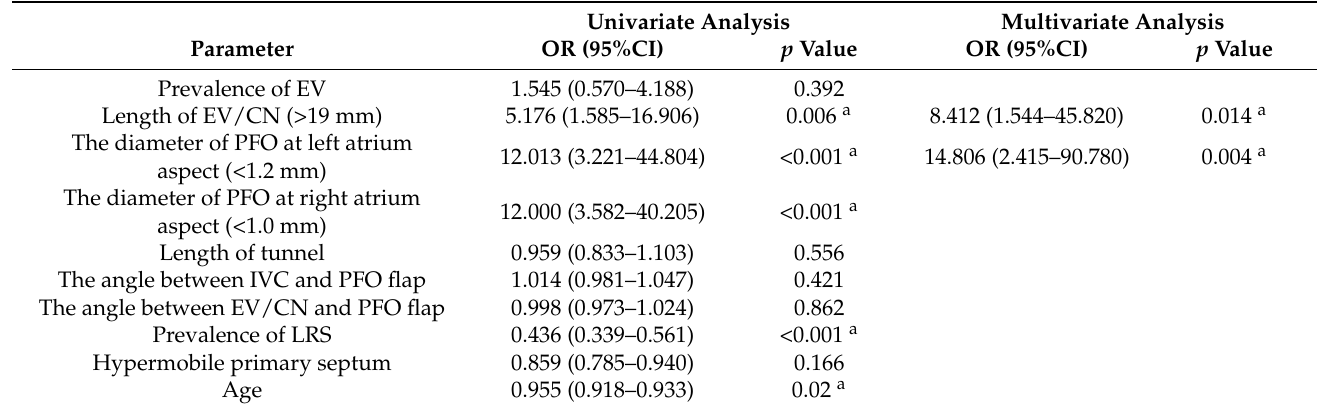
Table 3. Univariate and Multivariate Logistic Analyses for Factors Related to Missing PFO in Patients with EV/CN (N =